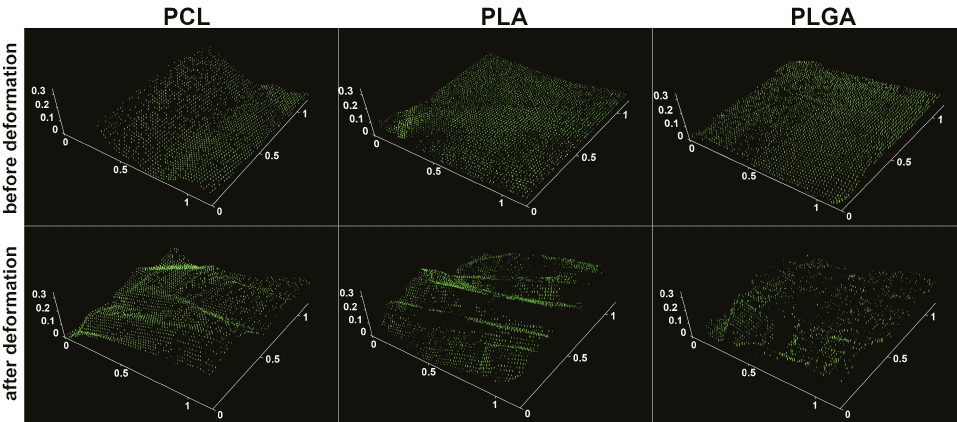
Figure 4. Confocal images of stents with PCL, PLA, and PLGA coating based on microchamber arrays before and after deformation in a delivery system. Cargo is FITC-dextran (5 kDa). The scale is in mm.